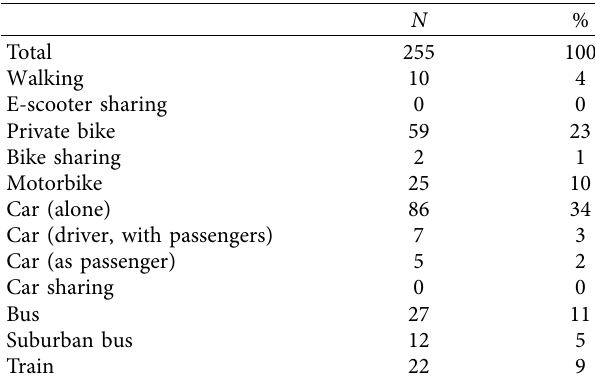
Table 5: Modal share of sample for